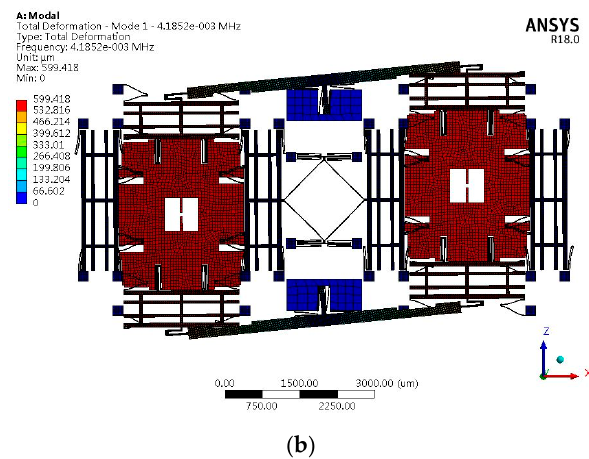
Figure 5. Anti-phase mode frequency in the sense direction of ( a ) type A1 and ( b ) type B.